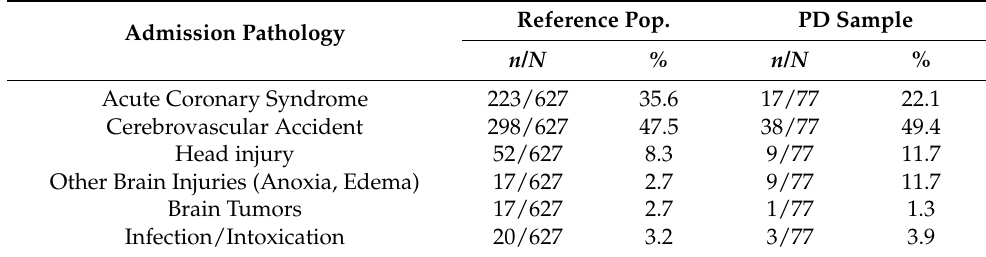
Table 4. Patient distribution according to admission pathology/exitus.